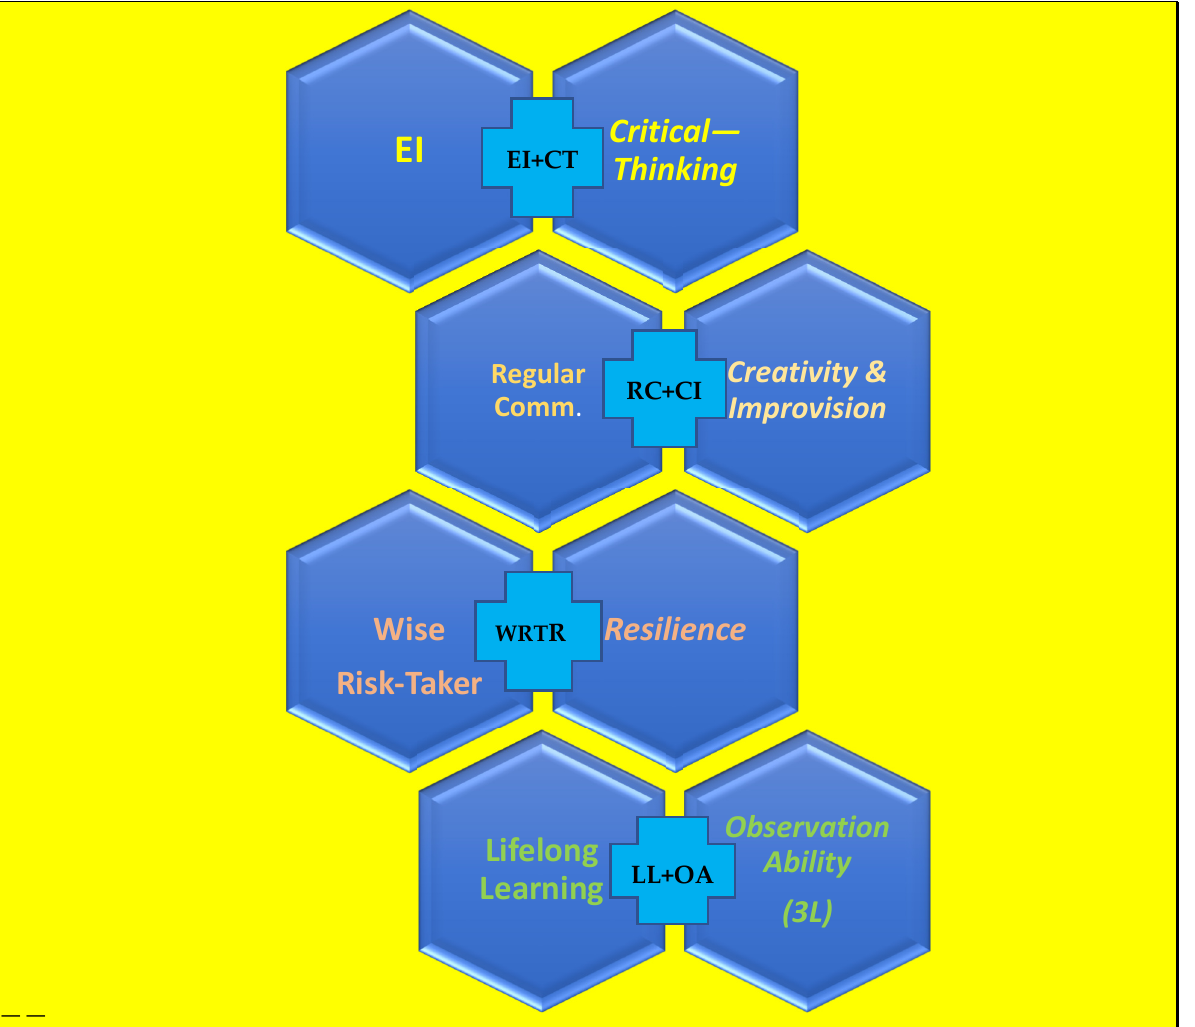
Figure 1. The inflection point for essential leadership requirements in e-recruitment: Leadership Complementary Skills (LCS) and the Honeycomb Complementary Skills Model.